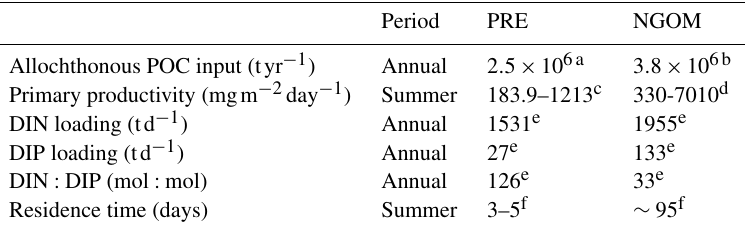
Table 4. A summary of the differences in physical and biogeochemical processes associated with the relative contributions of autochthonous versus allochthonous POC between the PRE and